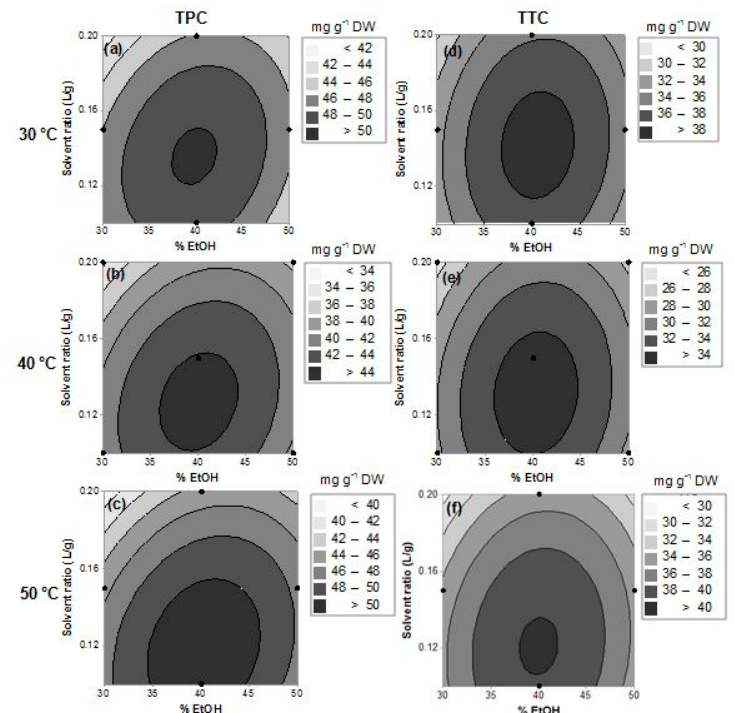
Figure 1. Response surface (contour plots) for predicting the TPC ( a – c ) and TTC ( d – f ) in Pistacia lentiscus leaf extracts with regard to the ethanol fraction (%, x 1 ) and solvent ratio (L g − 1 , x 2 ), at each temperature (x 3 , 30, 40, and 50 °C). The regions with the darkest-gray color represent the domains of working conditions assuring the maximum values for the evaluated compounds (total polyphenols and tannins).